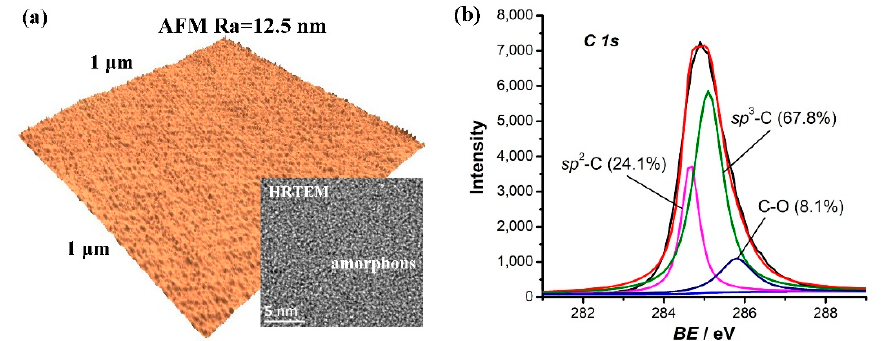
Figure 3. Structural characteristics of diamond-like carbon (DLC) coating (S3). ( a ) Nanoscale smooth surface indicated by AFM 3D morphology and an amorphous microstructure shown by an HRTEM image; ( b ) X-ray photoelectron spectrometer (XPS) fitting spectrum of C 1s taken from the surface layer. BE: Binding energy.